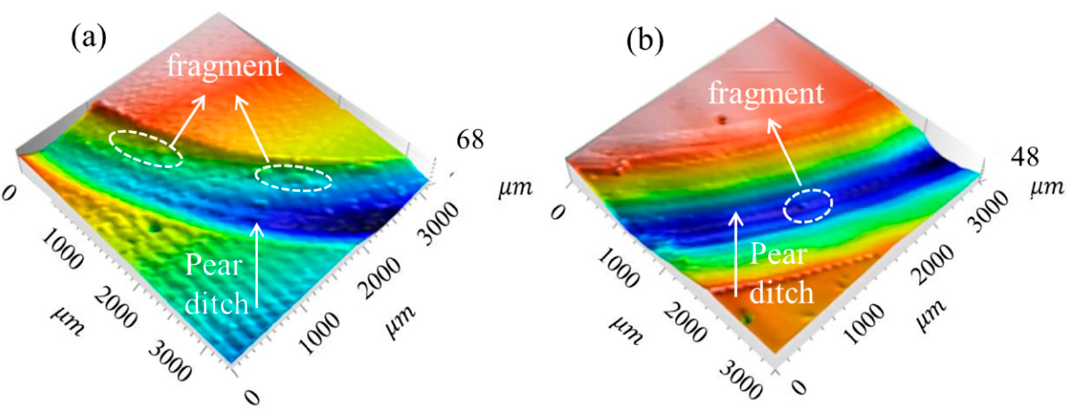
Figure 13. CoCrFeNiMnSn x HEAs coatings ( a ) Sn 0 and ( b ) Sn 0.2 under the same pressure wear 3D morphologies.